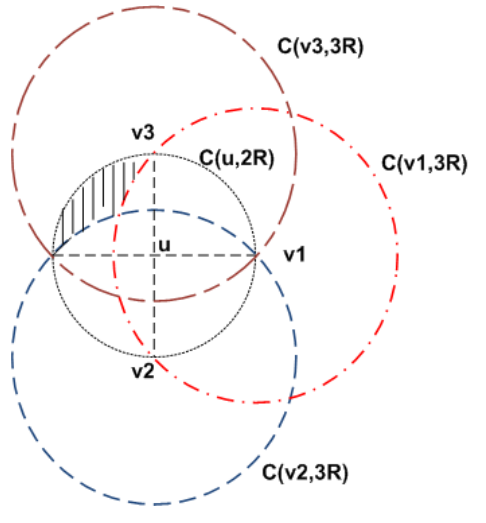
Fig. 1. Possible zone for node v 3 .